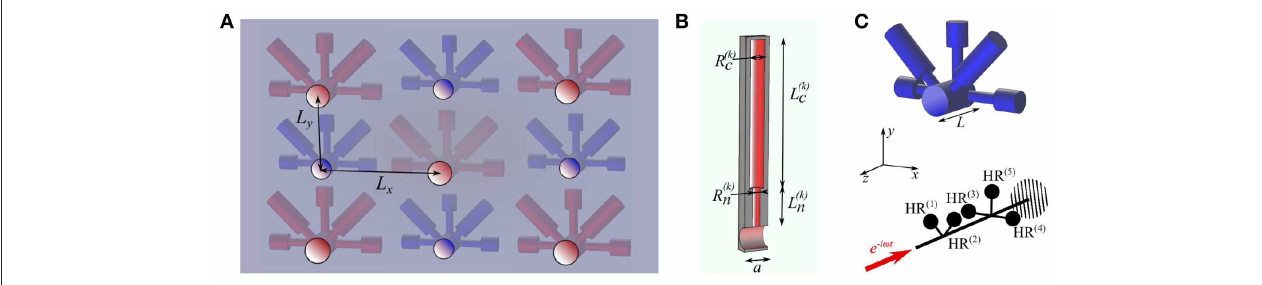
FIGURE 2 | (A) Sketch of a rigidly-backed transparent panel with cylindrical perforated cavities arranged in a rectangular lattice and loaded by five colored HRs. (B) The dimensions of a Helmholtz resonator. (C) Top: the geometry of a cavity loaded by five HRs; bottom: schematic diagram of the corresponding 1D analog with the red arrow indicating the direction of incident sound.